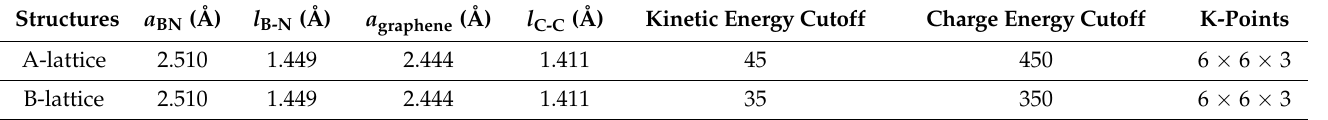
Table 1. Main initial structural parameters and some calculation